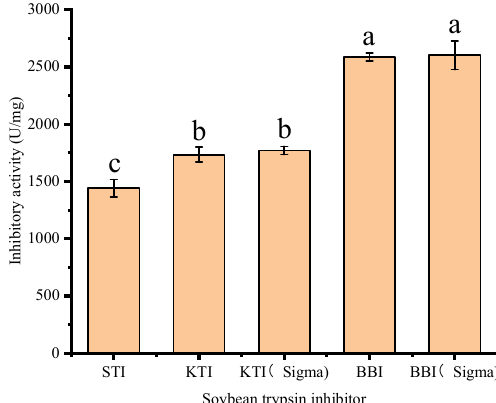
Figure 5. Analysis of soybean trypsin inhibitors activity. Different letters indicate significant differ- ences ( p < 0.05) among different soybean trypsin inhibitors.